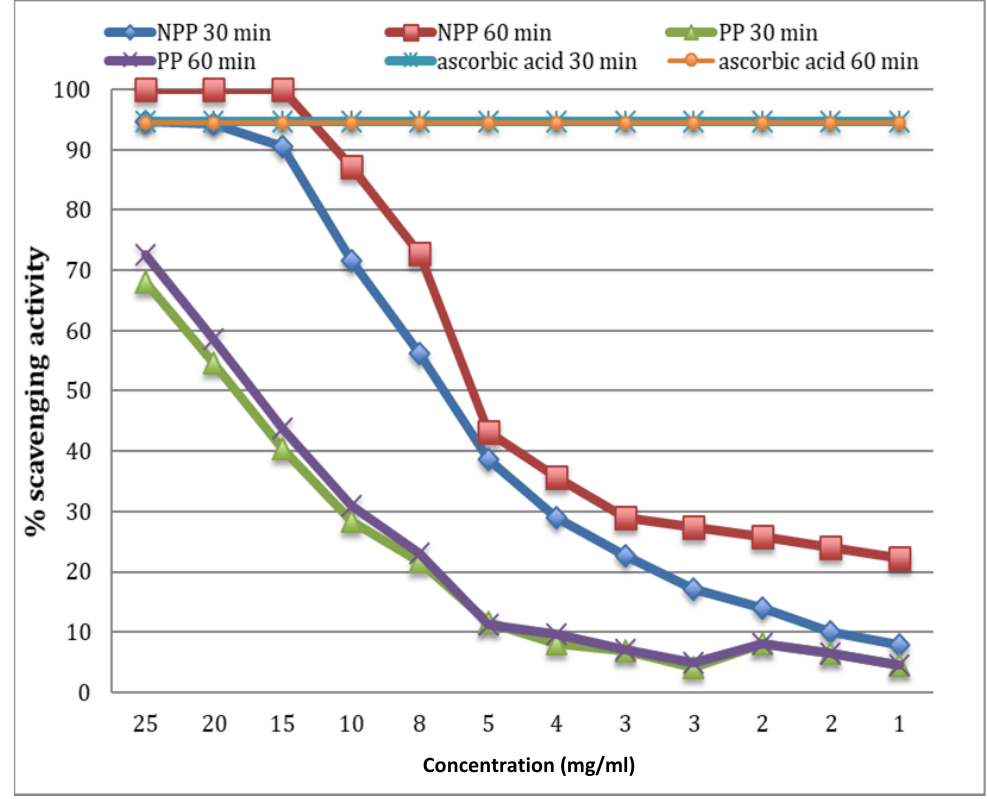
Figure 2. Scavenging activity on DPPH radical of ascorbic acid and extractable polyphenols from non-pasteurized pulp (NPP) and pasteurized pulp (PP) at 30 and 60 min.